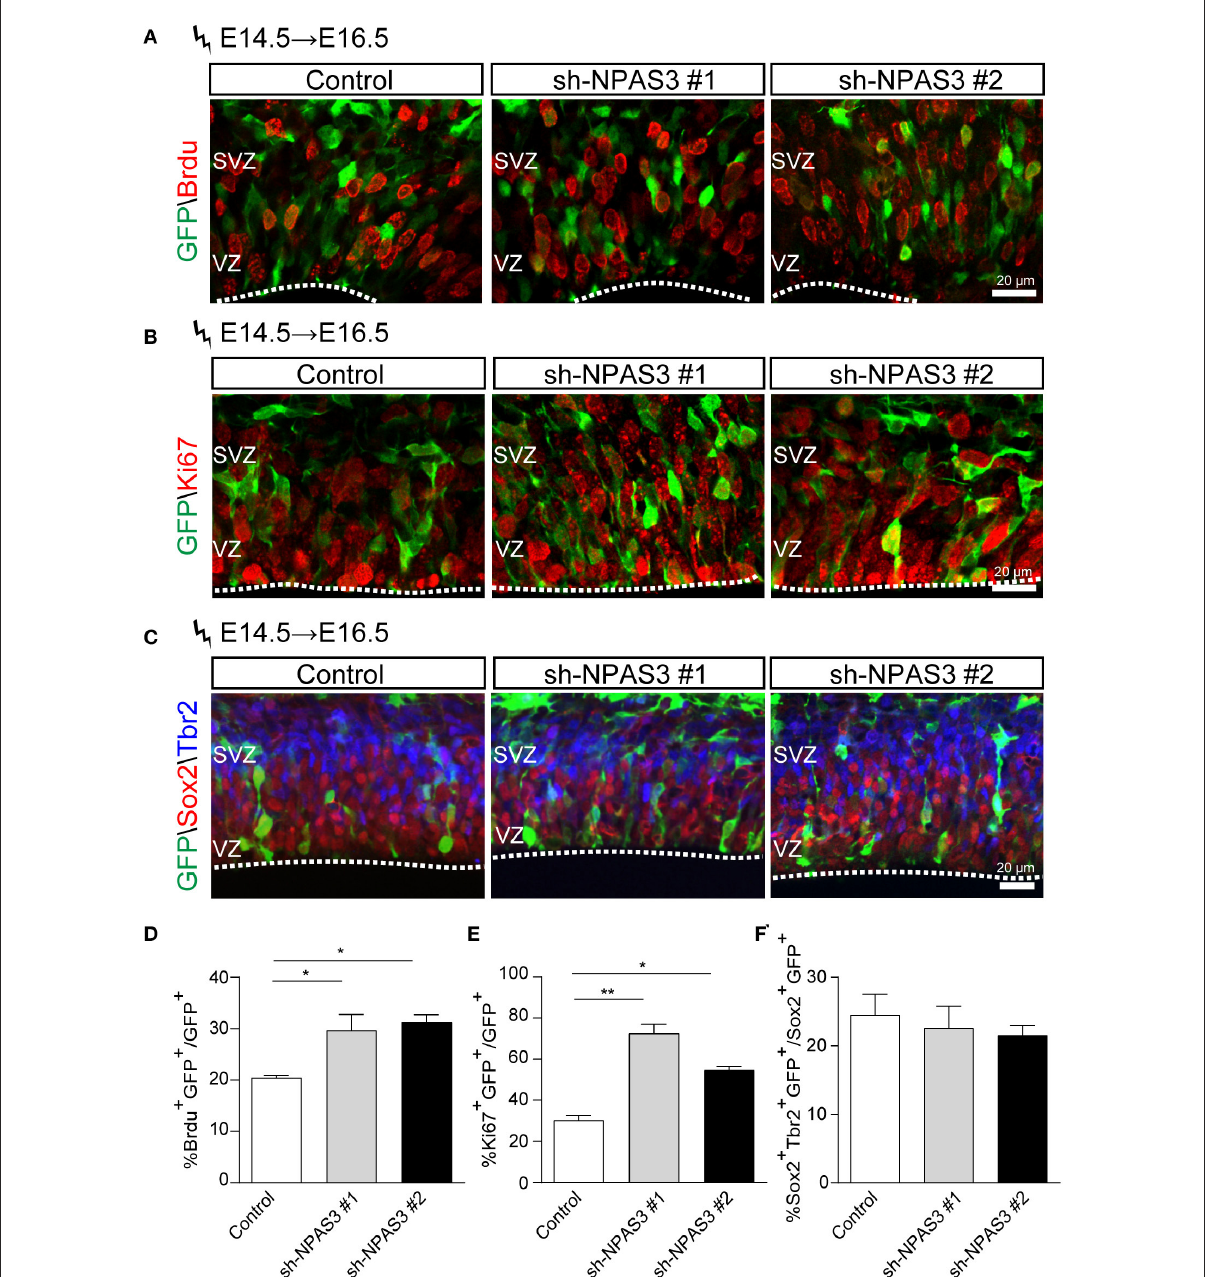
FIGURE5 Npas3 knockdown resulted in an increased proliferation rate of progenitors residing in VZ and SVZ. BrdU was injected into E16.5 pregnant mice 2 days after in utero electroporation. Mouse brains were collected 2h later after BrdU injection, and the brain sections were processed for immunostaining with antibodies against BrdU (A) , Ki67 (B) , and Sox2/Tbr2 (C) . Quantification of BrdU positive cells from (A) , Ki67 positive cells from (B) , and Sox2 + Tbr2 + (C) is shown in (D) , (E) , and (F) , respectively, as % of total electroporated cells, ± SEM ( n = 3–5). The asterisks indicate the statistically significant difference with respect to control mice (one-way ANOVA test, * p < 0.05, ** p < 0.01). VZ, ventricular zone; SVZ, subventricular zone.